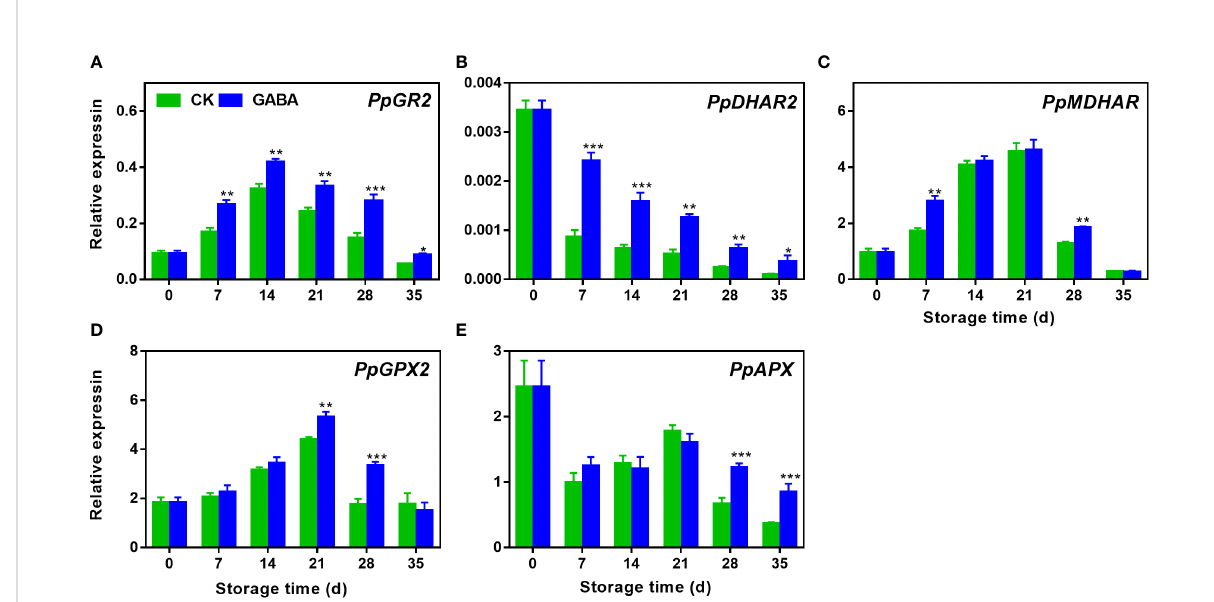
FIGURE 6 Effect of GABA treatment on expression of genes involved in ASA-GSH cycle of peach stored at 4°C. Expression levels of PpGR2 (A) , PpDHAR2 (B) , PpMDHAR (C) , PpGPX2 (D) and PpAPX (E) were analysed. Asterisks indicate signi fi cant differences between CK and GABA treatment (*p < 0.05, **p < 0.01, and ***p <